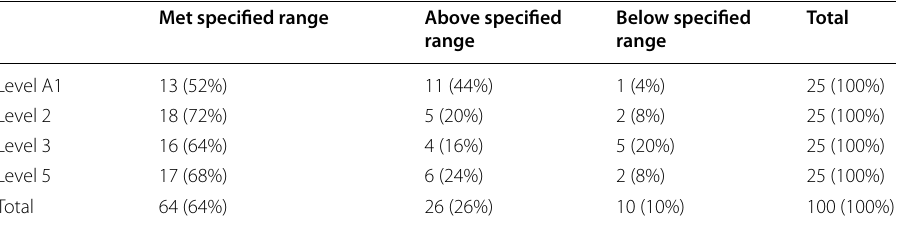
Table 2 The extent to which the 100 items meet the specified difficulty range (based on p -value and organized according to the test levels